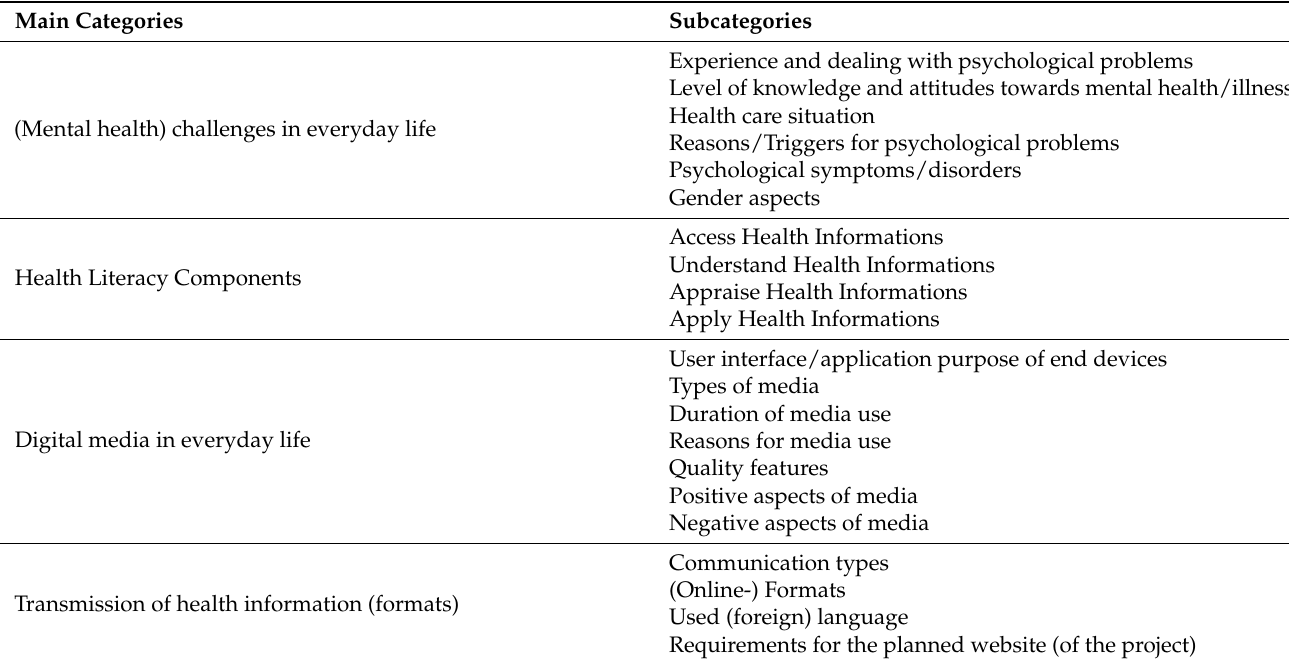
Table 2. The first two levels of the category